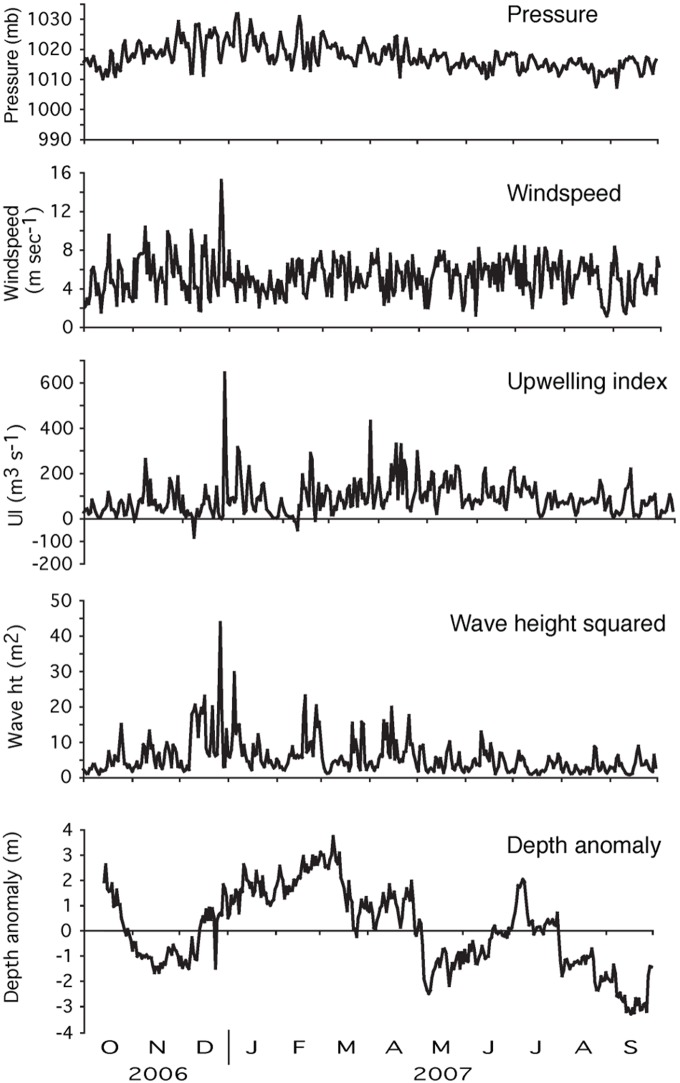
Time series plots of environmental variables and blue rockfish depth anomalies.Plots of mean daily barometric pressure (mb), wind speed (m sec−1), upwelling index (m3 s−1 100 m−1 of coastline), mean wave height (m2), and depth anomalies (m) of tagged blue rockfish. A daily depth anomaly was obtained by subtracting the annual mean depth of a given fish from the daily mean depth of that fish on each date of the study. Positive anomalies represent deeper mean depth than the annual mean depth; negative anomalies represent shallower mean depth than the annual mean depth.